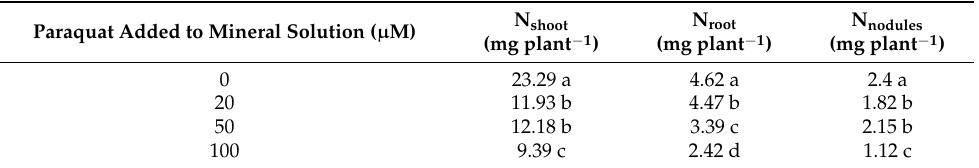
Table 4. Effect of paraquat addition on nitrogen content in shoot (N shoot ), root (N root ) and nodules (N nodules ) of soybean plants inoculated with B. diazoefficiens 110 spc 4.